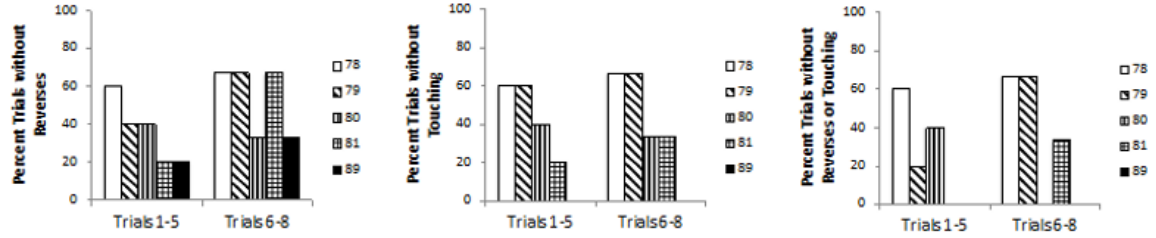
Note . Each bar represents the percentage of trials from a single turtle. The top graph shows the individual percent of trials without a reverse, the middle graph shows the individual percent of trials without touching the barrier, and the bottom graph shows the individual percentage of trials in which neither error was